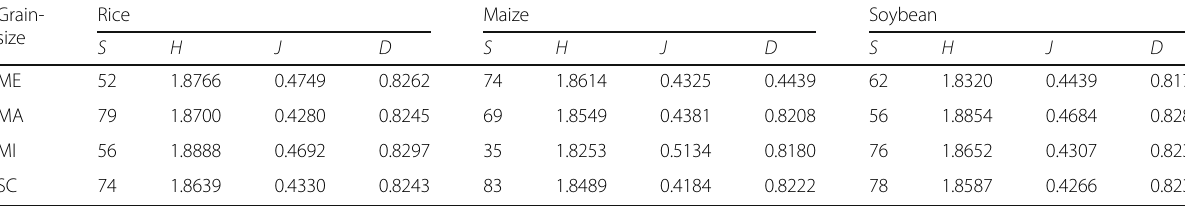
Table 2 Changes in S , H , J , and D associated with soil aggregate structure under different croplands Grain-